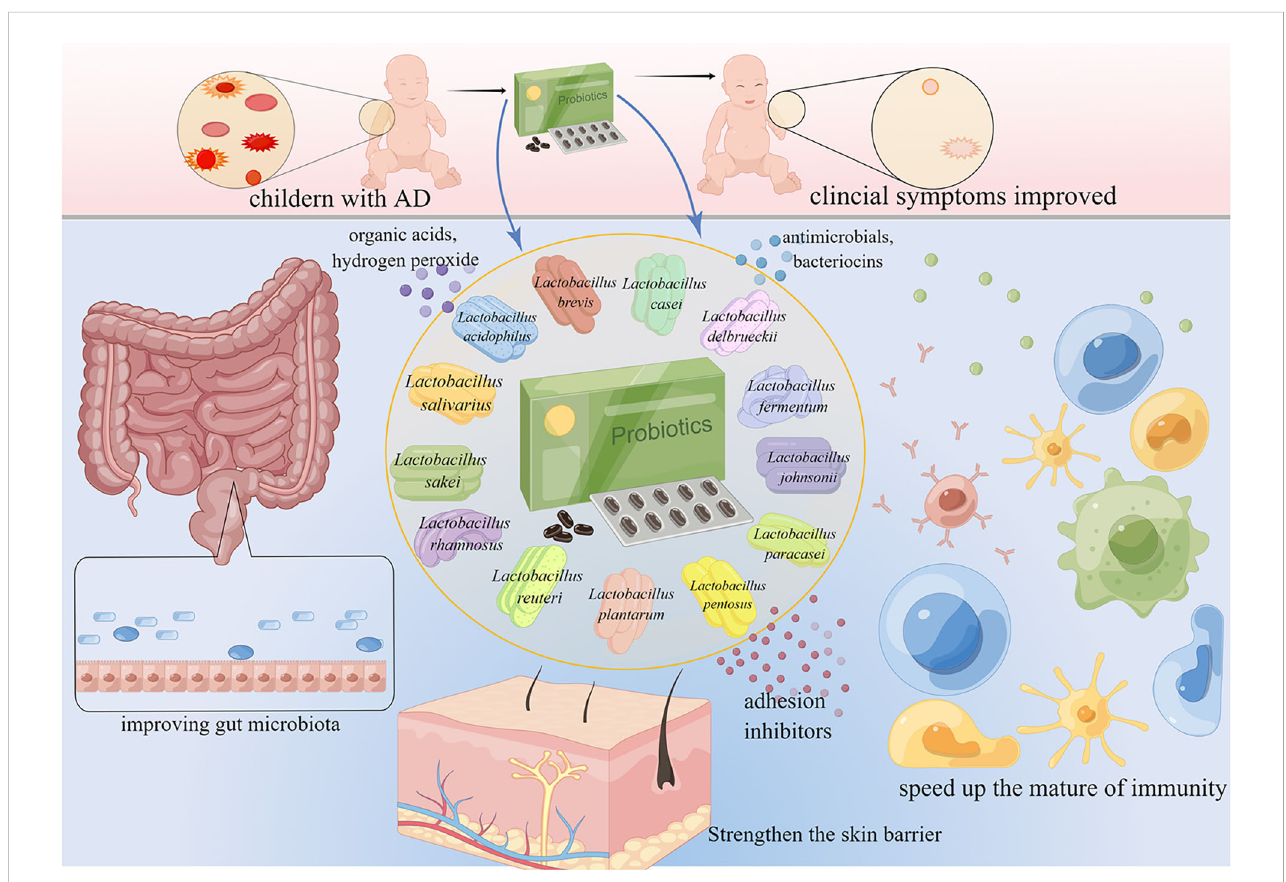
FIGURE 2 Lactobacillus for the treatment and prevention of AD. AD is common in children. Lactobacillus accelerates the maturation of the immune system, maintains intestinal homeostasis, improves the gut microbiome, and ultimately improves the symptoms of